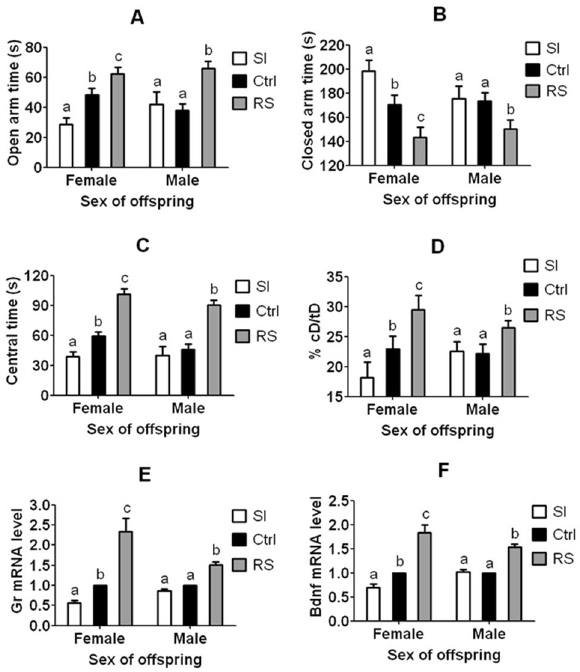
Figure 2. Anxiety-related phenotypes in female and male F1 offspring from F0 matings between unstressed mothers and social instability stressed (SI), restraint stressed (RS) or unstressed control (Ctrl) fathers. Graphs ( A ) and ( B ) show open and closed arm time of EPM, ( C ) and ( D ) show central area time and % central distance (cD)/total distance (tD) of OFT, and ( E ) and ( F ) show relative levels of hippocampal Gr and Bdnf mRNAs, respectively. The % of central distance (cD)/total distance (tD) of OFT was calculated by dividing the total distance a mouse traveled during the 5 min test by the distance it traveled within the central area. a–c: Values with a different letter above bars differ significantly ( P < 0.05) within offspring sexes. Data from behavioral tests in graphs ( A ), ( B ), ( C ) and ( D ) were analyzed using LMM, whereas data from qRT-PCR in graphs ( E ) and ( F ) were analyzed using ANOVA. The P value refers to the fixed effect in the LMM procedure while it refers to the main effect in the ANOVA Test. Numbers and litters of F1 offspring used and the significance of difference ( P values) for EPM, OFT and qRT-PCR are shown in Supplemental Tables S2, S3 and S4,